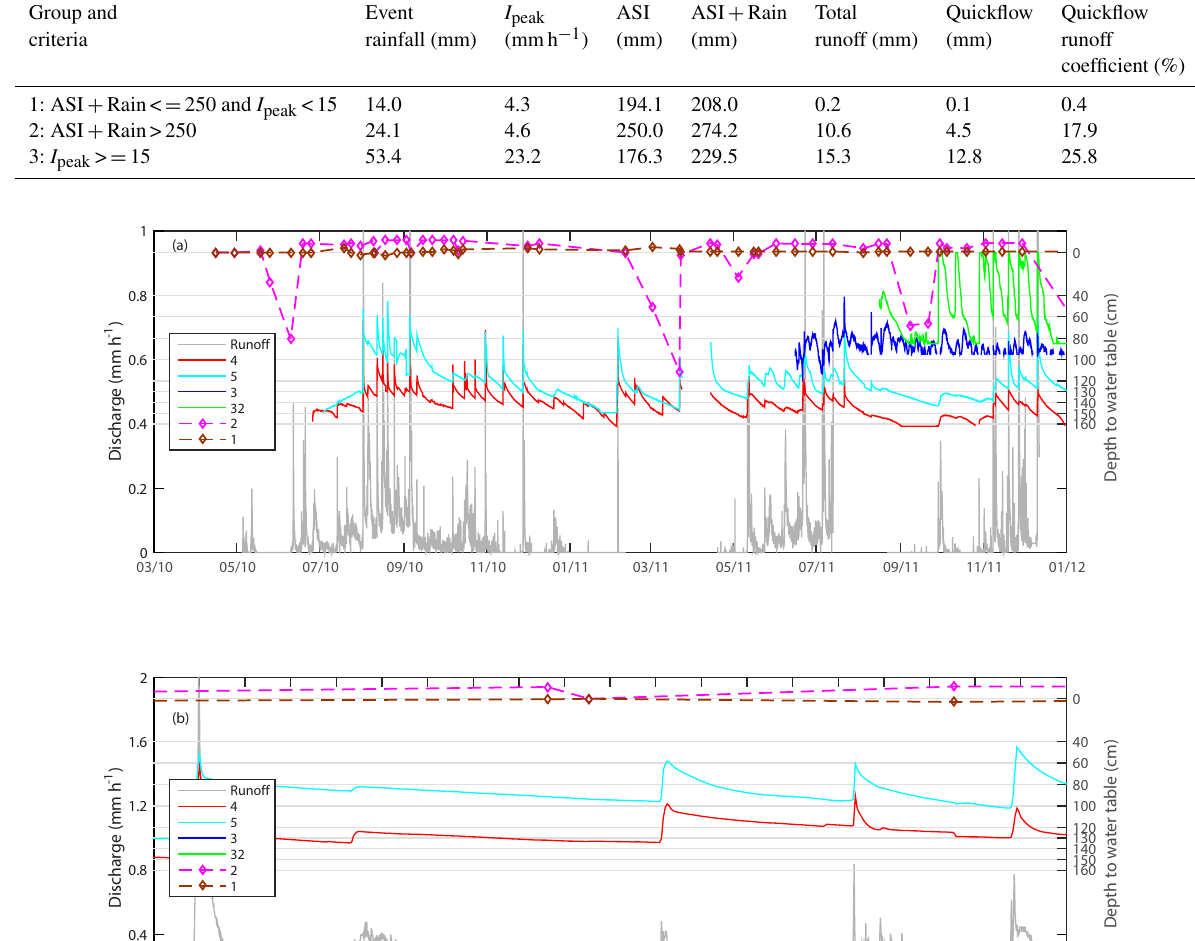
Table 3. Average characteristics for each event group. ASI is the Antecedent Soil moisture Index. Group and Event I peak Quickflow criteria